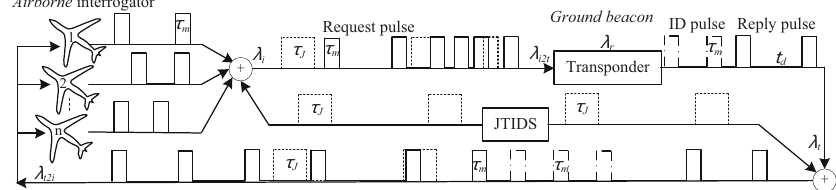
Figure 4. The signal flowchart of DME suffering from inter-system and intra-system